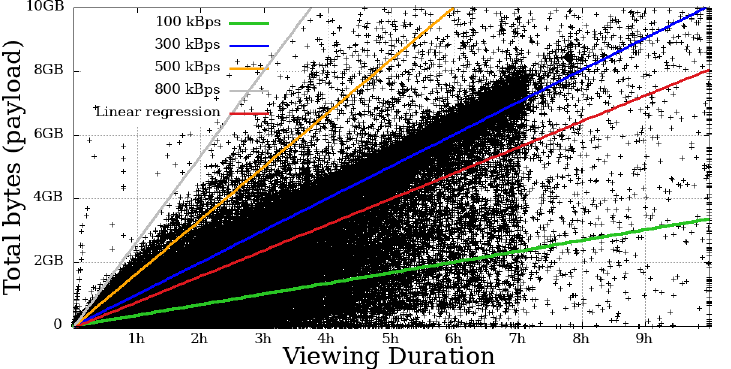
Figure 15. Bytes throughput per second of non-mobile users on the system in the broadcast Impeach- ment start session— Camara dos Deputados .